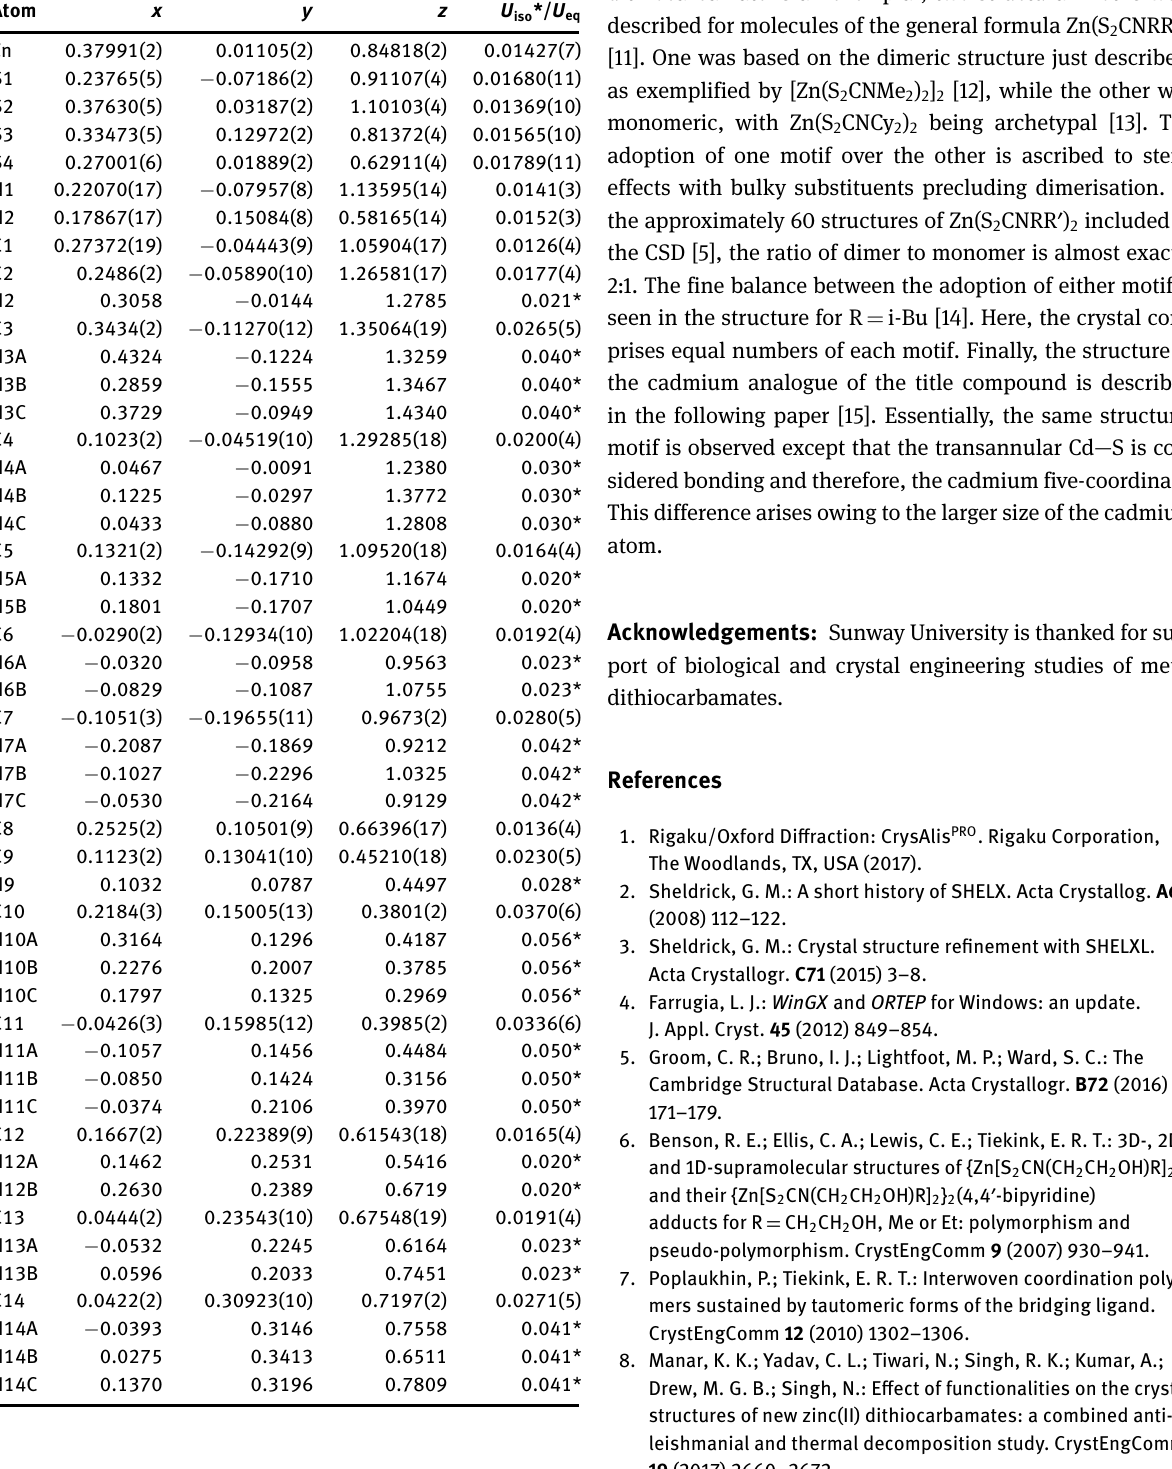
Table 2: Fractional atomic coordinates and isotropic or equivalent isotropic displacement parameters (Å 2 ).